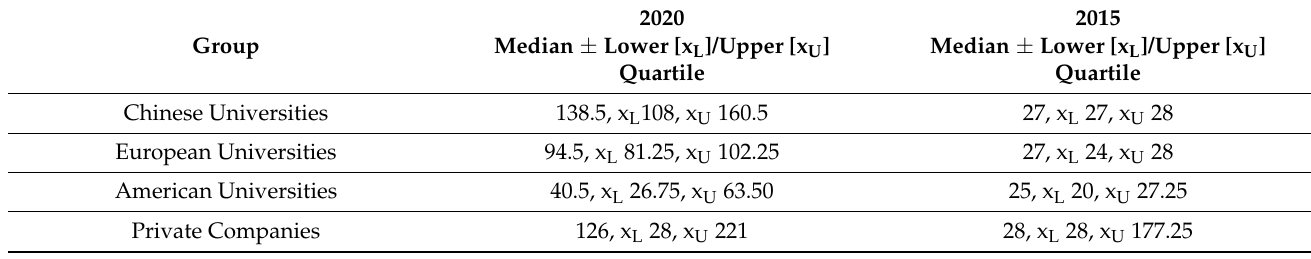
Table 7. Trends between groups 2010–2020 in sub-indicator “Sociality” in the best 30 universities of China, the European Union, the US, and in private companies.